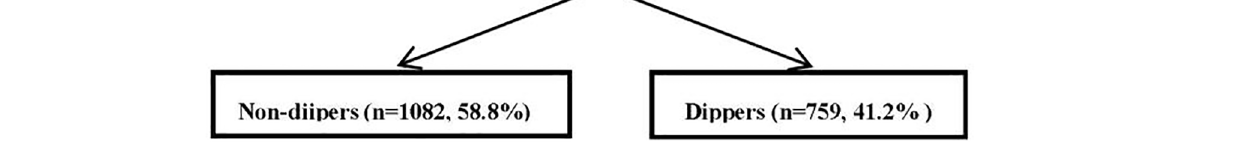
FIGURE 1 Study recruitment fl owchart. OSA, obstructive sleep apnea; ABPM, ambulatory blood pressure